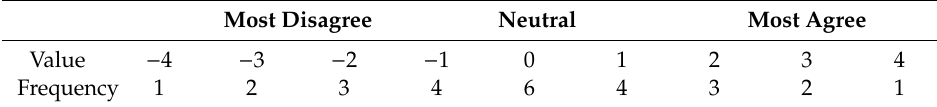
Table 1. Q-sort distribution for 26